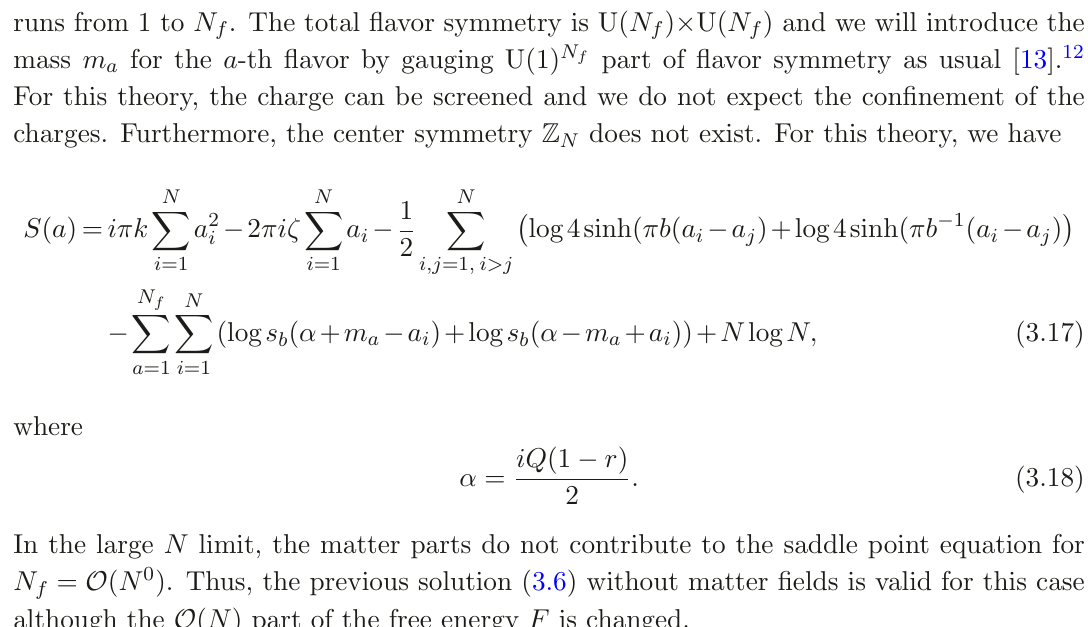
Figure 1 . The left figure shows the numerical plot of N = 400. The horizontal axis corresponds to k when k < N and k is integer. The right figure shows (3.16) as a function of t . The zeros only appear in t 1 ≤